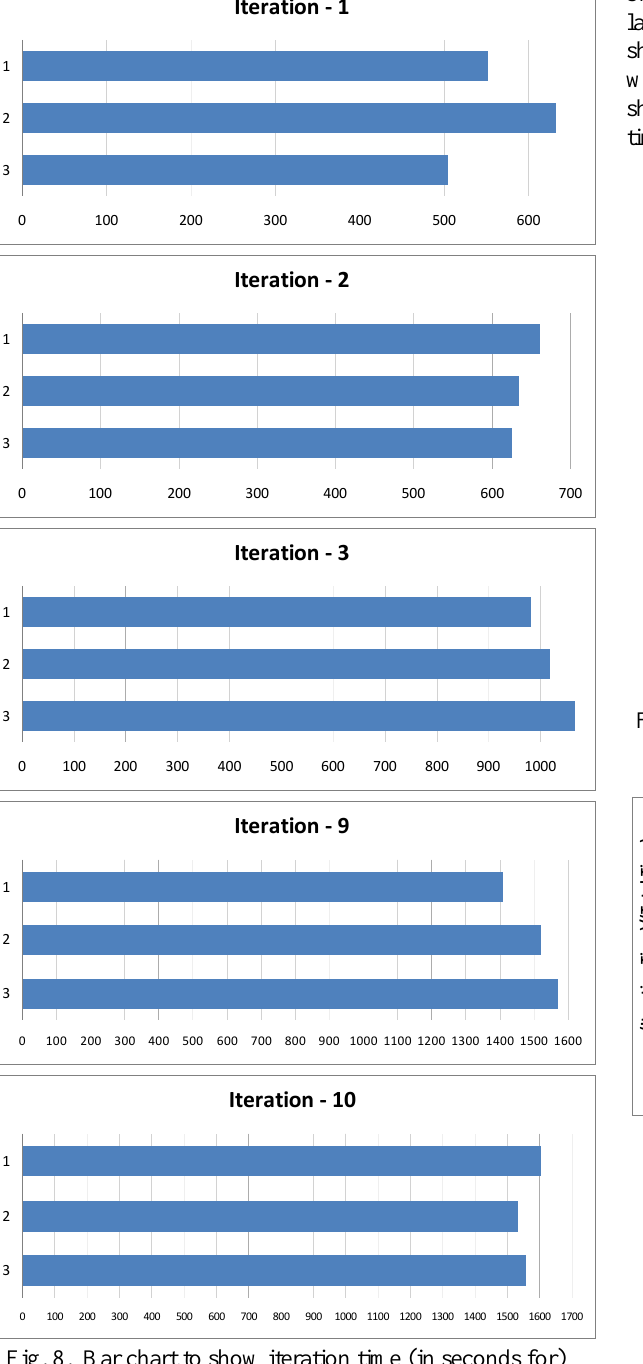
Fig. 8. Bar chart to show iteration time (in seconds for) every processor (for n = 4) for 3-DV case p